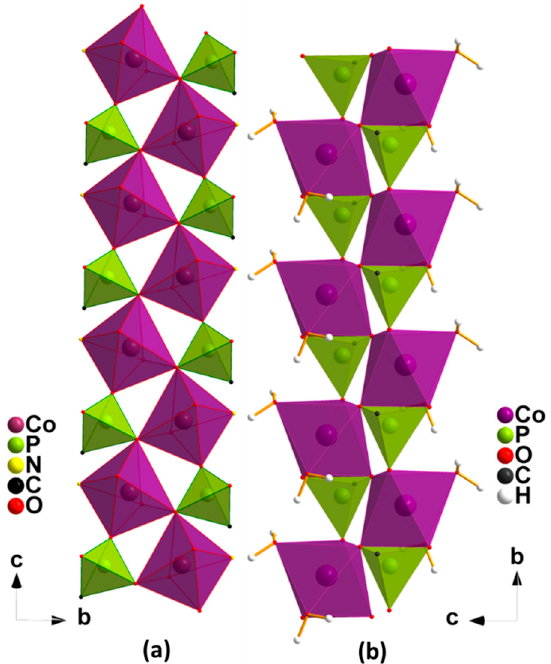
Figure 3. ( a ) Projection of the structure of Co(H 2 O) 2 PO 3 C–C 12 H 9 · H 2 O along the a axis without fluorene groups; ( b ) Projection of Co(H 2 L)(H 2 O) along the a axis without the organic part, adapted from the reference [30].